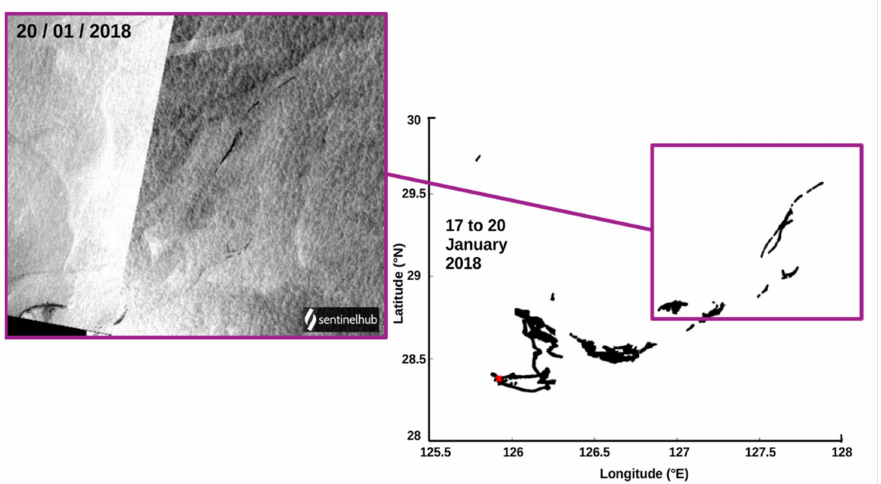
Figure 4. East China Sea oil spill trajectory from the 17th to 20th of January 2018 detected by SAR